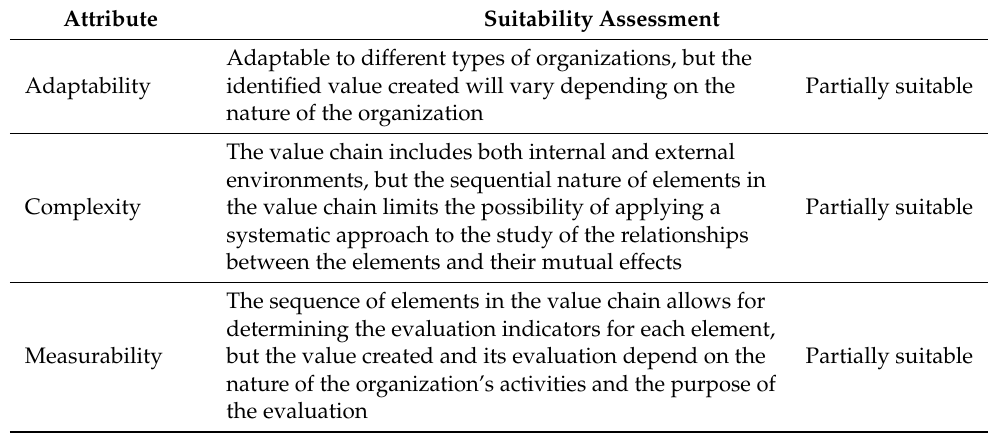
Table 7. Suitability assessment of the value chain approach according to identified attributes.